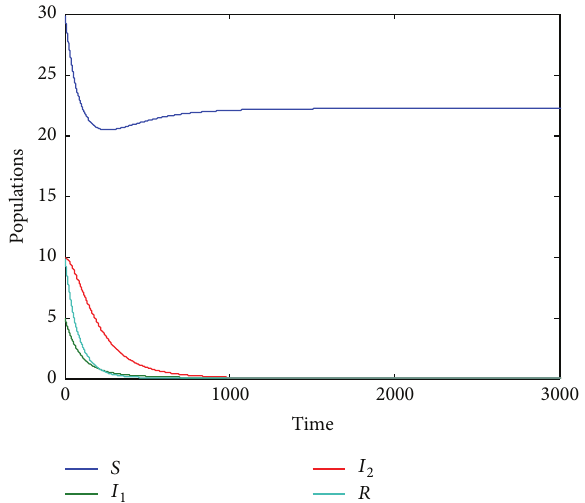
Figure 2: Time series of the solution of model (1) that approaches asymptotically to DFE for the data